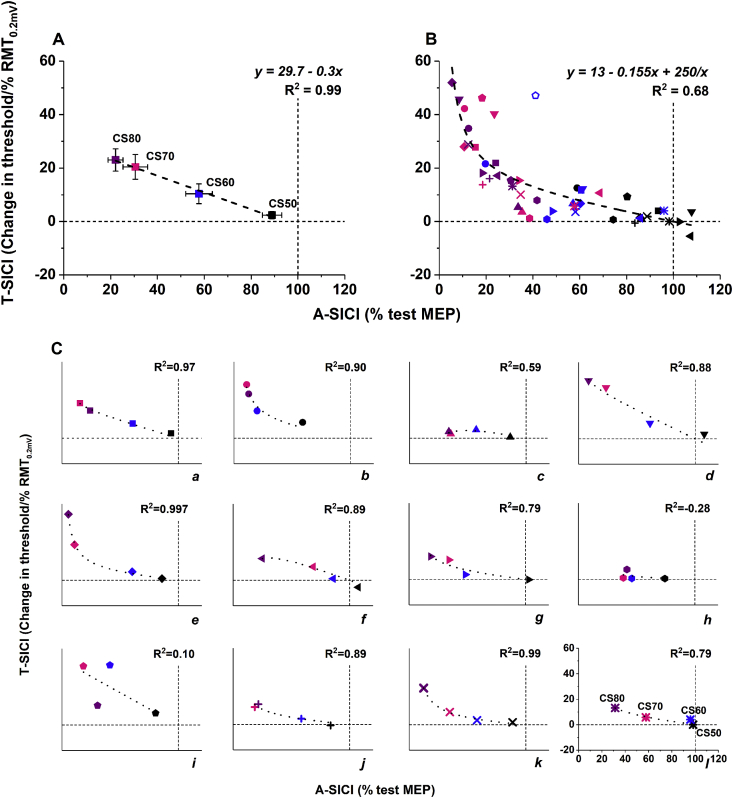
Relationship between A-SICI and T-SICI recruitment curves. Scatter plots demonstrate the relationship between mean SICI recruitment curves obtained by conventional technique (x axis) and threshold-tracking (y axis). Dotted lines indicate control conditions (100% test MEP for A-SICI, 0% RMT0.2mV for T-SICI). A) A strong linear relationship between the mean group SICI obtained by the two techniques. Group means were obtained by averaging SICI at matching conditioning stimulus levels (indicated by colours and labels: black/CS50 - CS 50% RMT0.2mV; blue/CS60 - CS 60% RMT0.2mV; pink/CS70 - CS 70% RMT0.2mV; purple/CS80 - CS 80% RMT0.2mV; dashed line – linear fit, error bars – standard error of the mean). B) A non-linear relationship between individual SICI means averaged across four sessions for each subject. Individual SICI recruitment curves from C) were superimposed (symbols represent different subjects and correspond to symbols in C); colours – conditioning stimulus levels as in A); dashed line - best fitting curve with two parameters satisfying the boundary conditions y = 0 when x = 100 and y = infinity when x = 0 [y = a(100-x)+b(100-x)/x]). Fit further improved when an outlier (open symbol) was removed (y = 9.94–0.127x+276/x, R2 = 0.78). C) The relationship between A-SICI and T-SICI varied among individuals over the same range of conditioning stimulus levels. Data points indicate SICI averaged across four sessions (symbols correspond to subject's symbol in B); colours and labels indicate conditioning stimulus levels as in A) and B); thick dotted line – fitted curve y = a(100-x)+b(100-x)/x). In almost half of the subjects, the relationship was near linear (e.g., a, d, l), while a ‘floor effect’ with conventional method was observed in others (e.g., b, e). In some subjects, no apparent correlation between A-SICI and T-SICI recruitment curves was seen (e.g., i). (For interpretation of the references to colour in this figure legend, the reader is referred to the Web version of this article.)